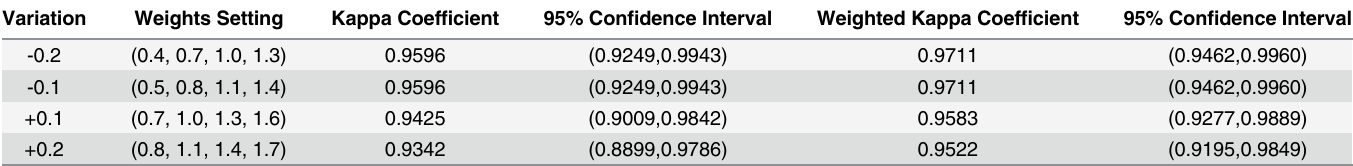
Table 7. Sensitivity analysis of four subjective weights with